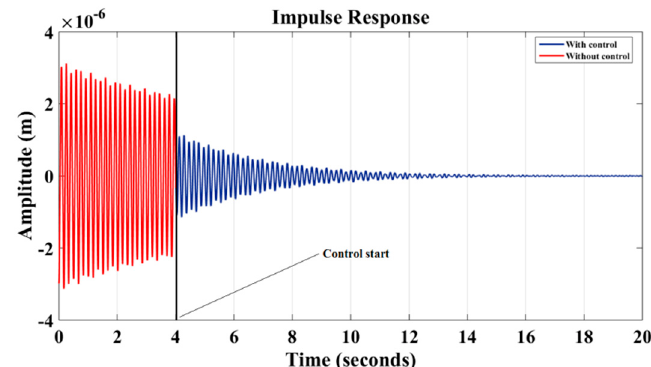
Figure 6. White noise response (Sensors in FE1, Q = 10 13 , R = 1, Gc = 100).